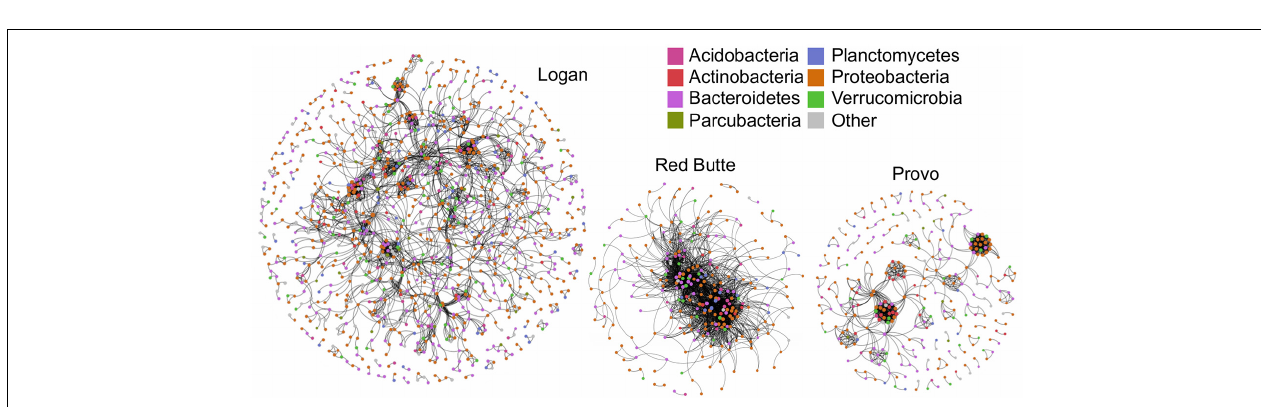
FIGURE 6 | Observed richness and Shannon diversity of bacterial communities for three watersheds over three seasons in Wasatch Range Metropolitan Area (WRMA). Boxes depict interquartile ranges, with the center line on the median and whiskers showing the extent of values.